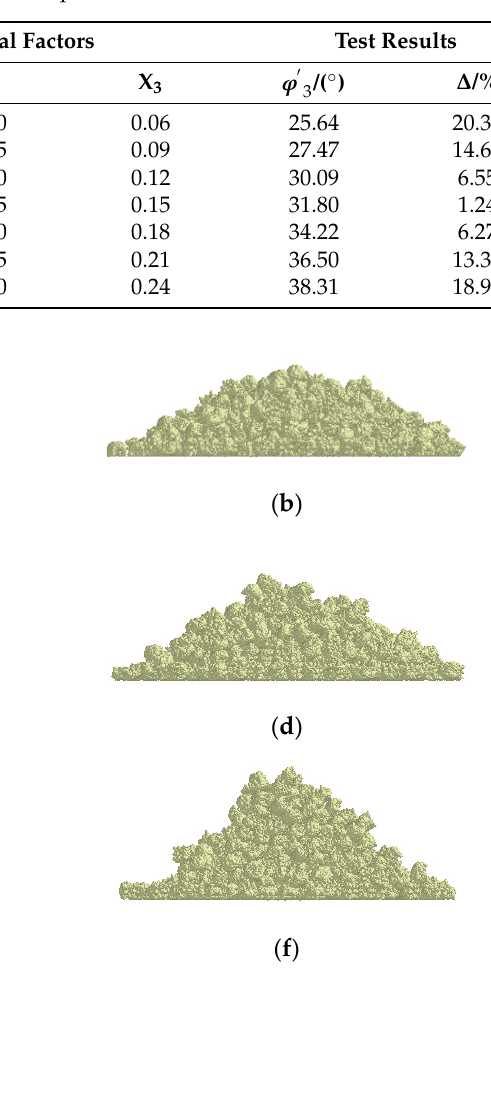
Table 6. Scheme and results of steepest ascent experiment.